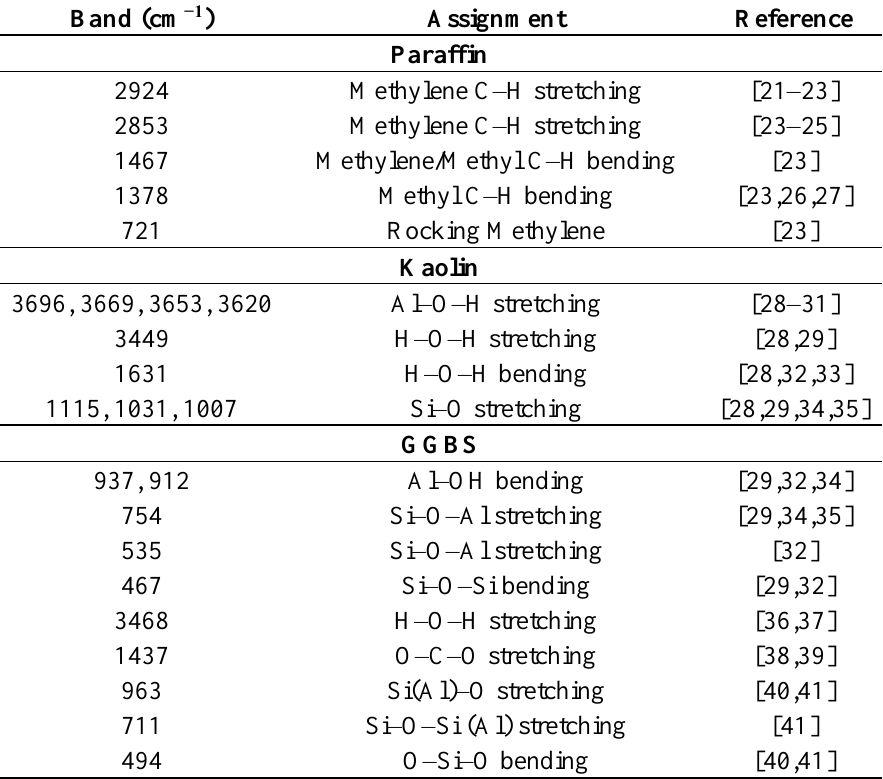
Table 3. FT-IR absorption bands and